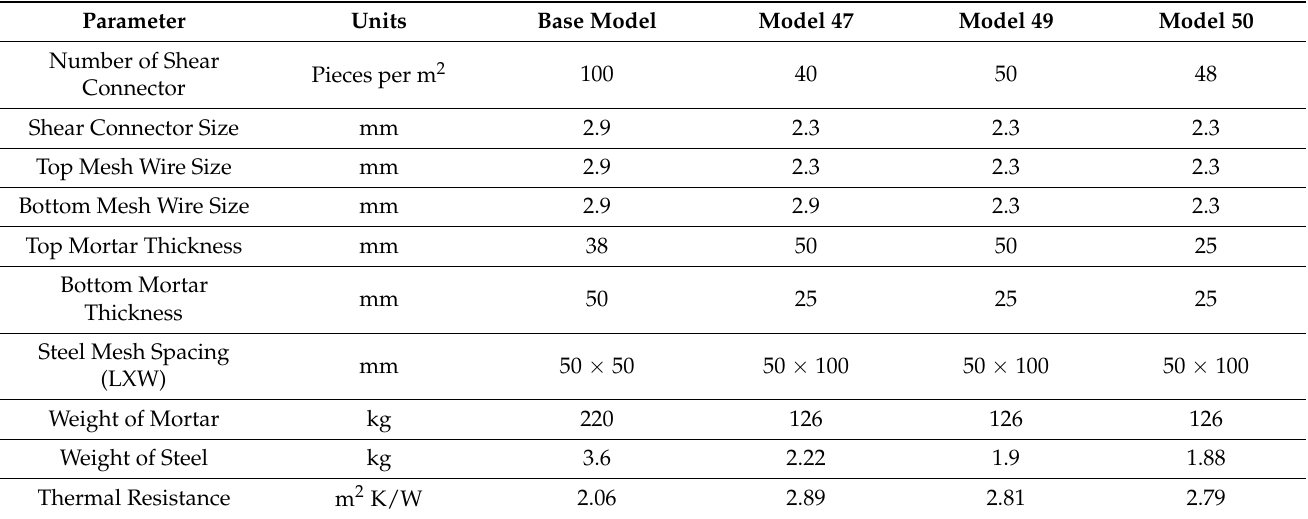
Table 7. CSP specifications comparison 10th generation to base model.